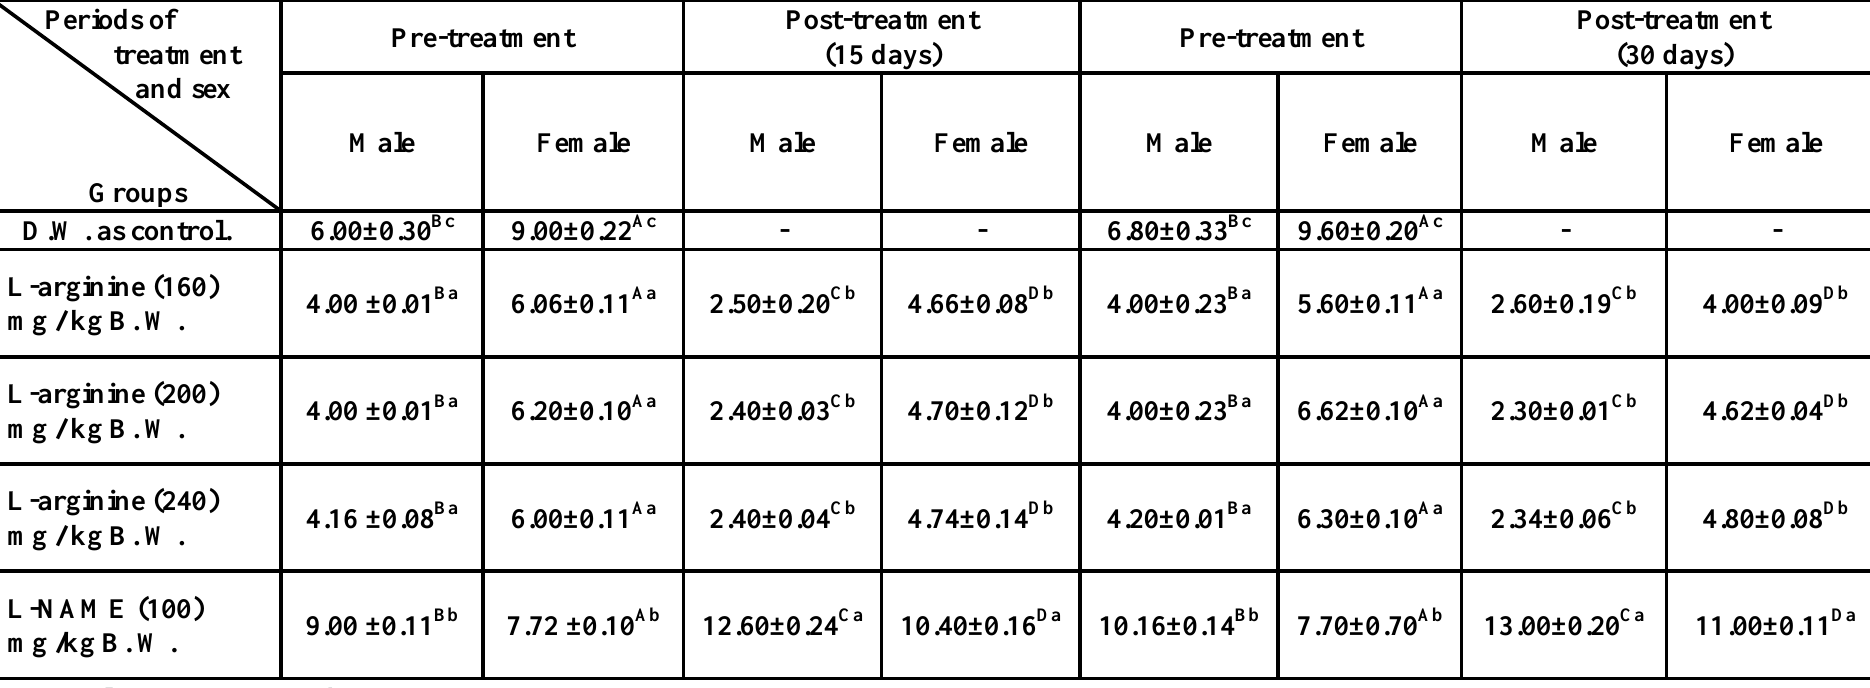
Table (1): The effect of L-arginine treated orally and L-NAME intraperitoneally daily on tail flick analgesic test latency period (second) in male and female